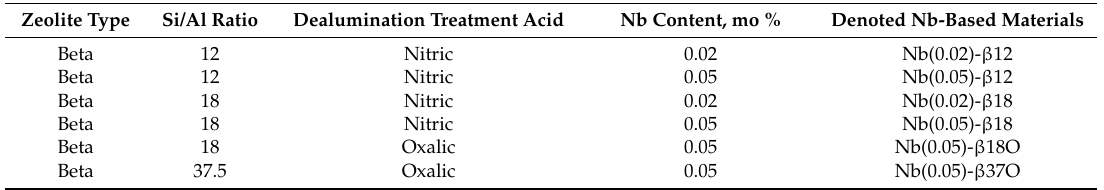
Table 6. The prepared catalytic